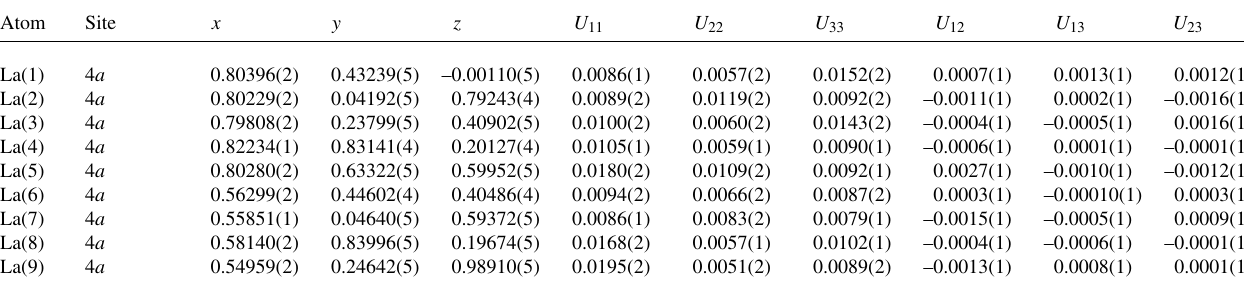
Table 3. Atomic coordinates and displacement parameters (in Å 2 ) .